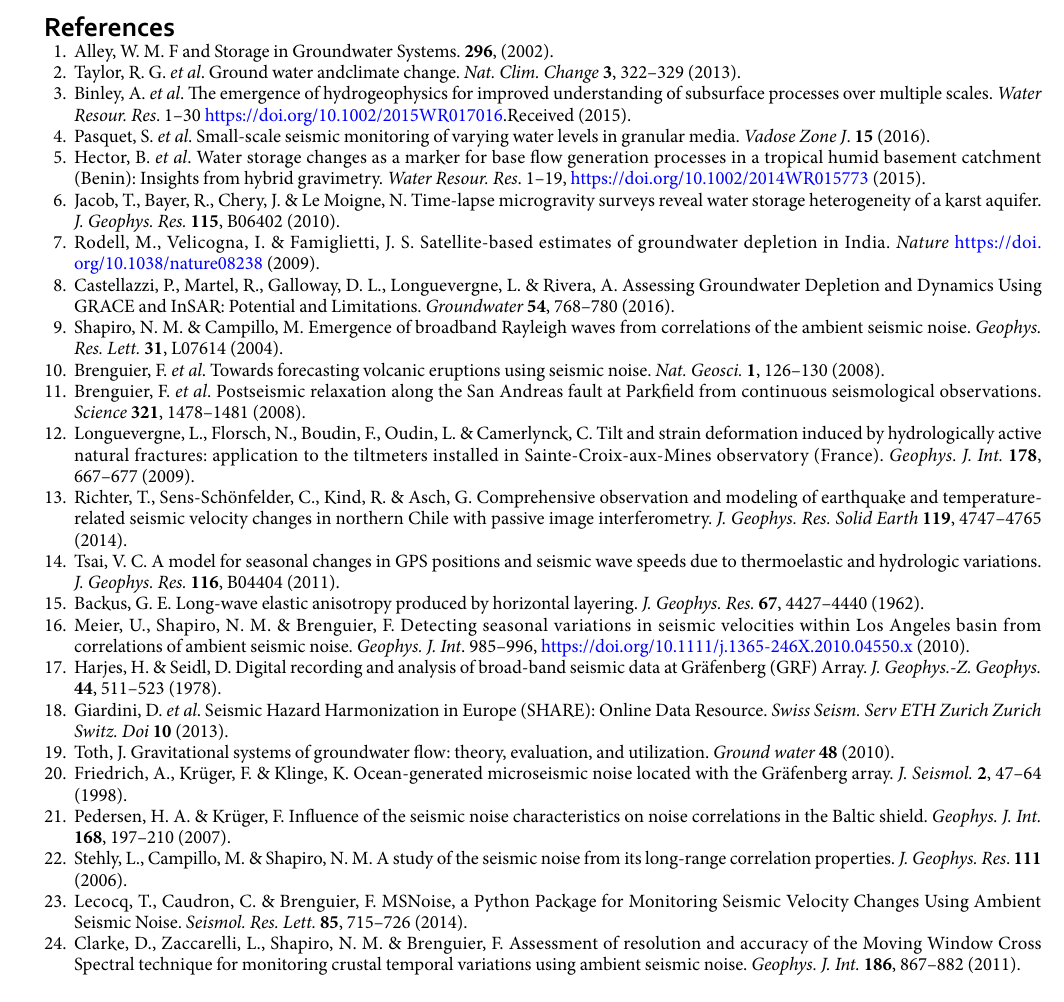
runoff and infiltration) and a “routing” store mimicking deep layer behavior (slow storage, contribution to river base flow). Although the model is conceptual, it has been successfully applied to represent the significant ground- water contribution to Nepal rivers 37 . The model is calibrated using a Marquard-Levenberg least-square approach on the logarithm of water discharge to limit the impact of floods and promote the description of low flows (groundwater contribution). We also add a volumetric constraint, imposing that mean modeled and observed discharge should agree within 2%. RMS error is small, only 20% of the discharge standard deviation. Modeled discharge does not represent well floods, though, the long-term evolution of base flow, including its significant interannual variations are well reproduced by this simple model (Fig. 14). Water storage change in the “routing” store is here used to compare to seismic velocity variations and named “groundwater storage variations”. Modeled groundwater storage is transformed into pressure head to be com- pared to groundwater pressure observations (Fig. 5C) considering an apparent 3% porosity, which is coherent with the hosting limestone aquifer 23,58–62 .